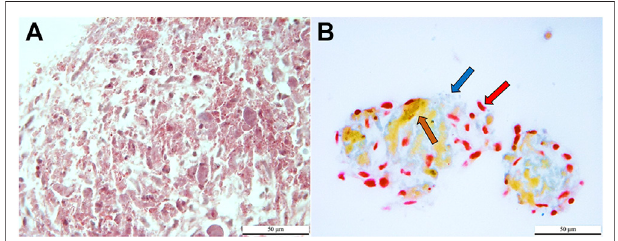
FIGURE 6 | Light photomicrographs of feline ASCs after three-stage cultureinstromal (A) orpancreaticinduction (B) medium stainedwithMallory- Heidenhan Azan-Gomori ’ s modi fi cation stain [ α cell granules (red arrow): red; β cellgranules(brownarrow):orange-brown; δ cellgranules(bluearrow): blue]. Scale bars = 50 µm.